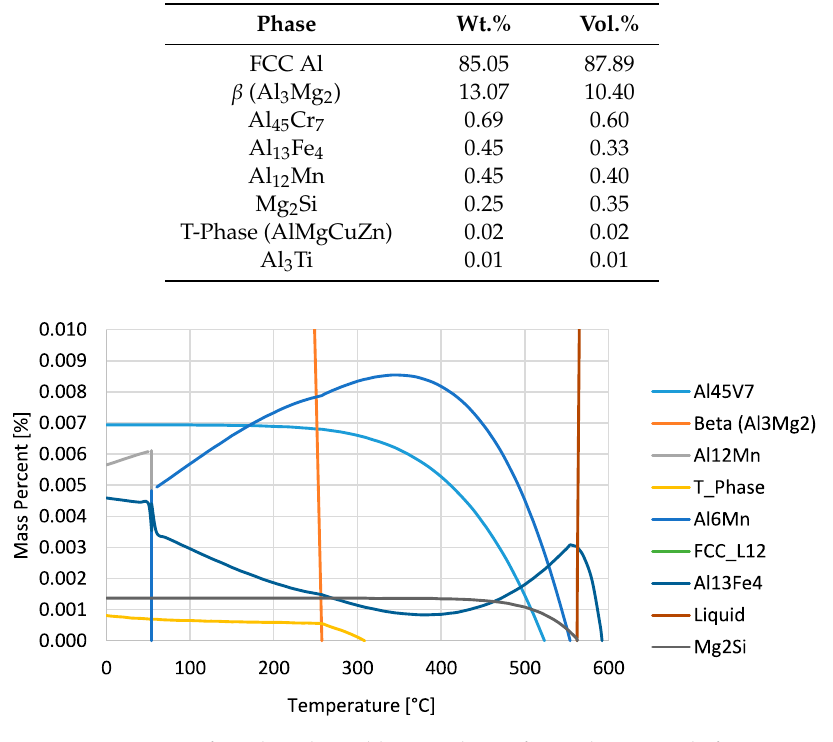
Figure 18. Mass percentage of predicted equilibrium phases from Thermo-Calc for gas-atomized Al 5056 as a function of temperature.